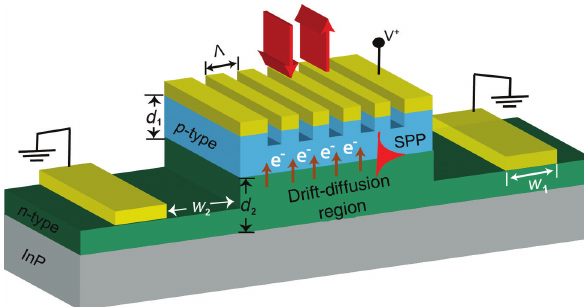
Figure 1: Basic schematic of the surface plasmon polariton diode